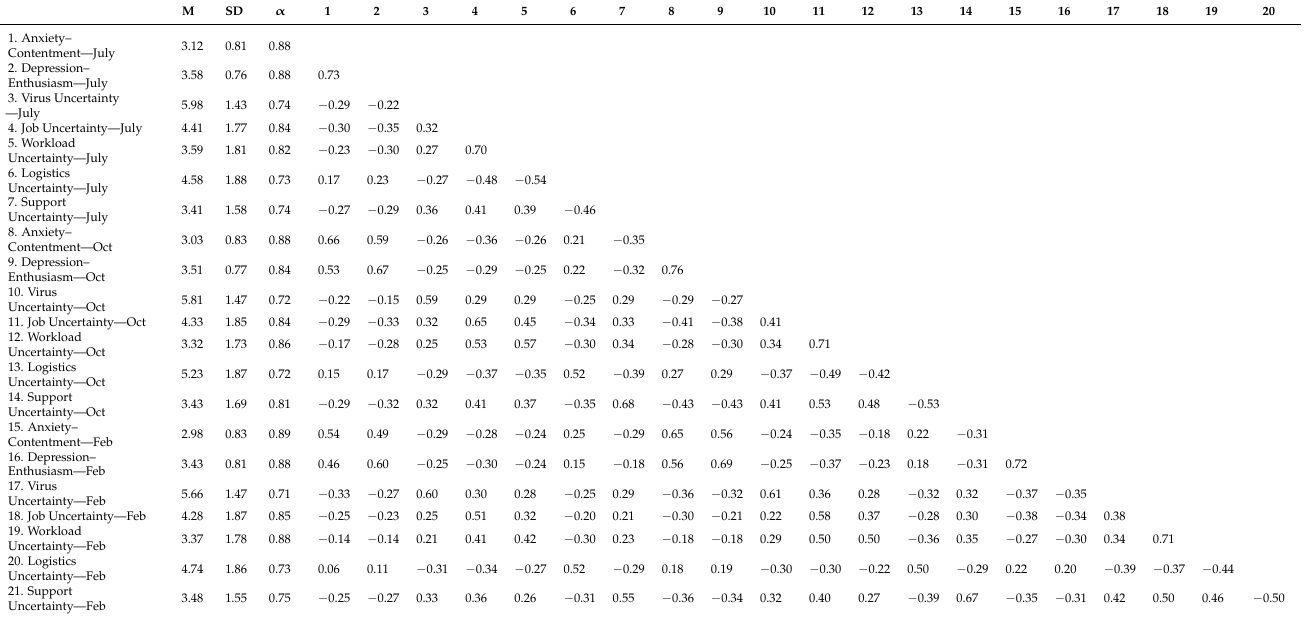
Table 3. Descriptive statistics and inter-correlations between the main study variables among the three-wave sample ( N =